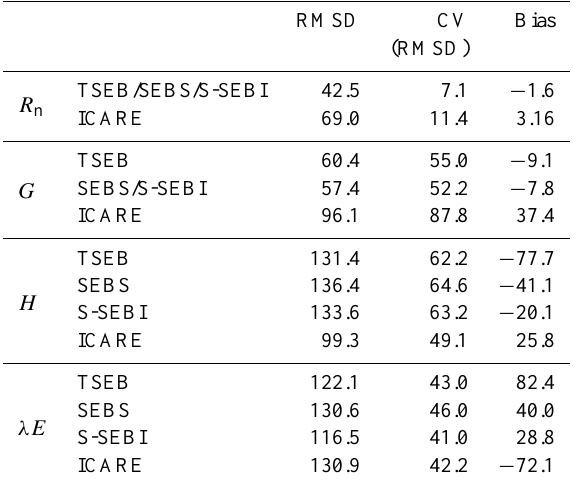
Table 3. Performance statistics of the models for the four compo- nents of the energy balance (in Wm − 2